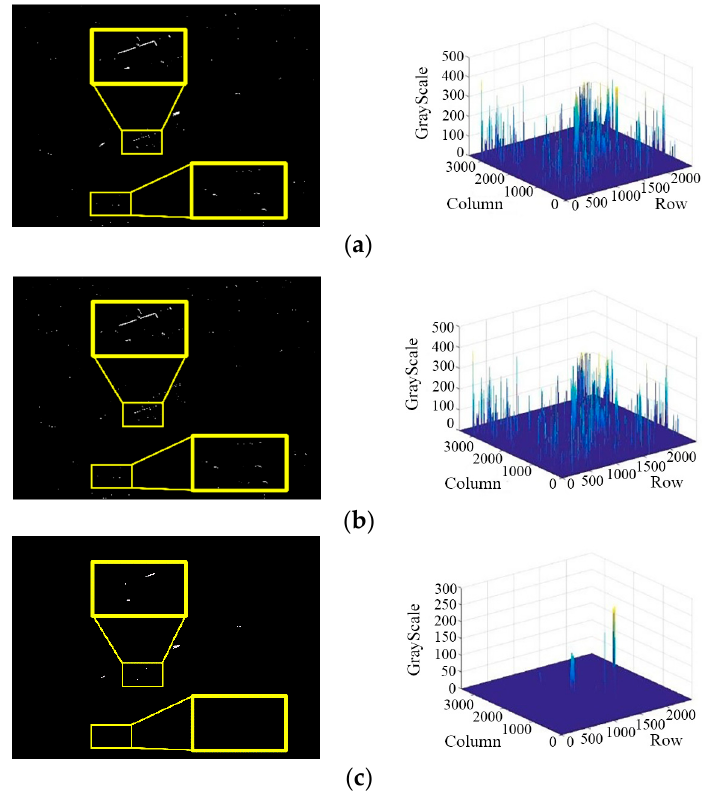
Figure 8. Comparison between top-hat filtering and multi-structuring element filtering: ( a ) Original Data; ( b ) Top-hat filtering result; ( c ) Multi-structural filtering result.